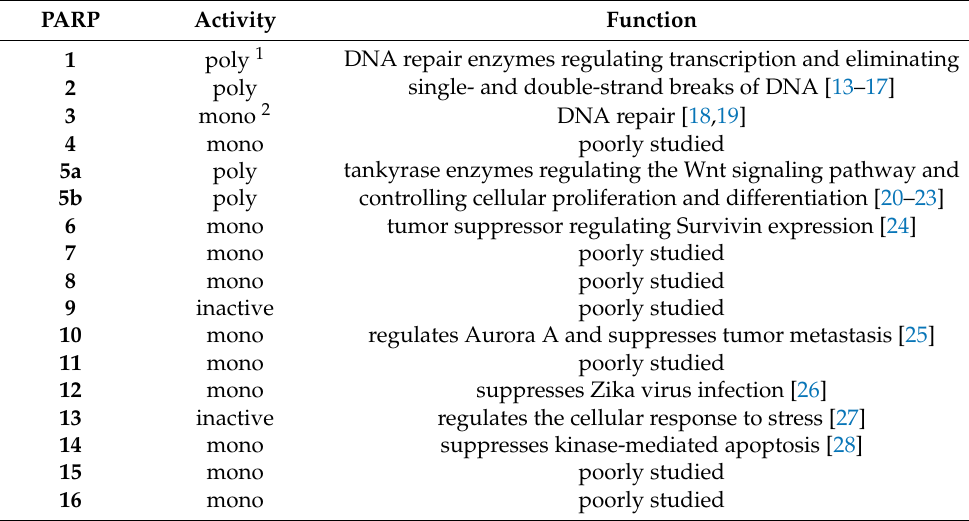
Table 1. Catalytic activity and cellular functions of PARP family proteins.